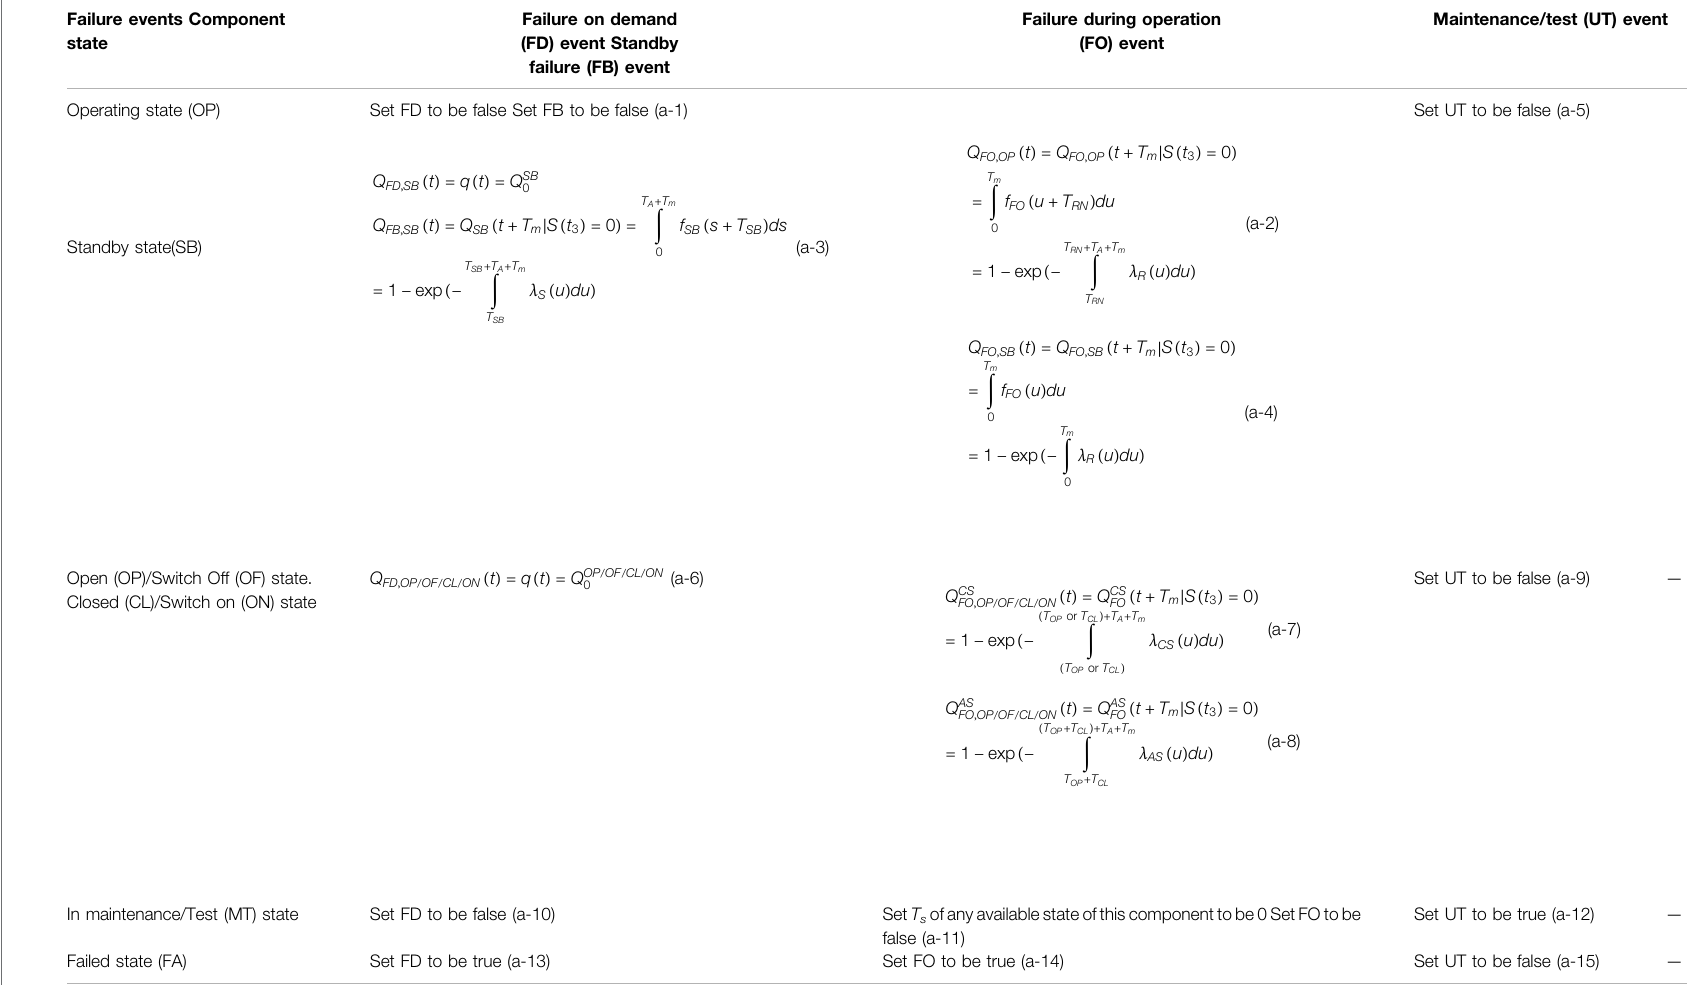
TABLE A2 | Time-dependent probability of failure events in the RORM